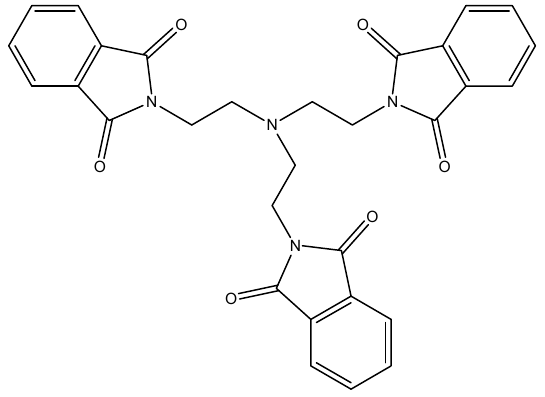
Figure 6. Structure of N,N ′ ,N ′ ′